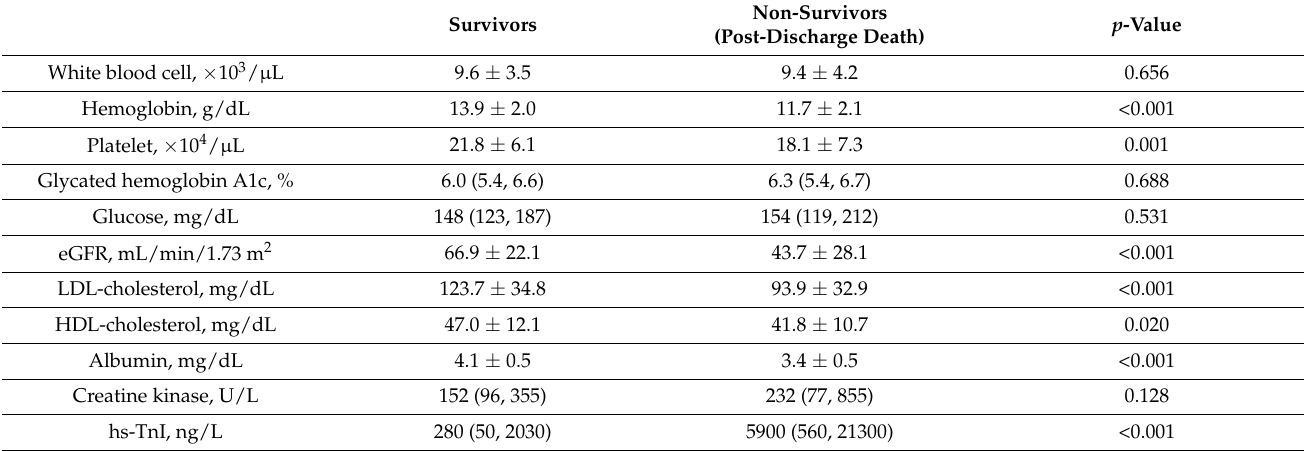
Table 2. Univariate analysis of laboratory variables associated with post-discharge death.